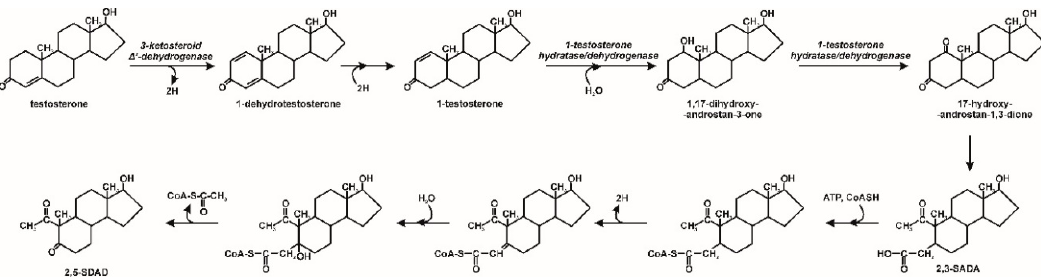
Figure 6. Testosterone biodegradation by bacteria in anoxic conditions;